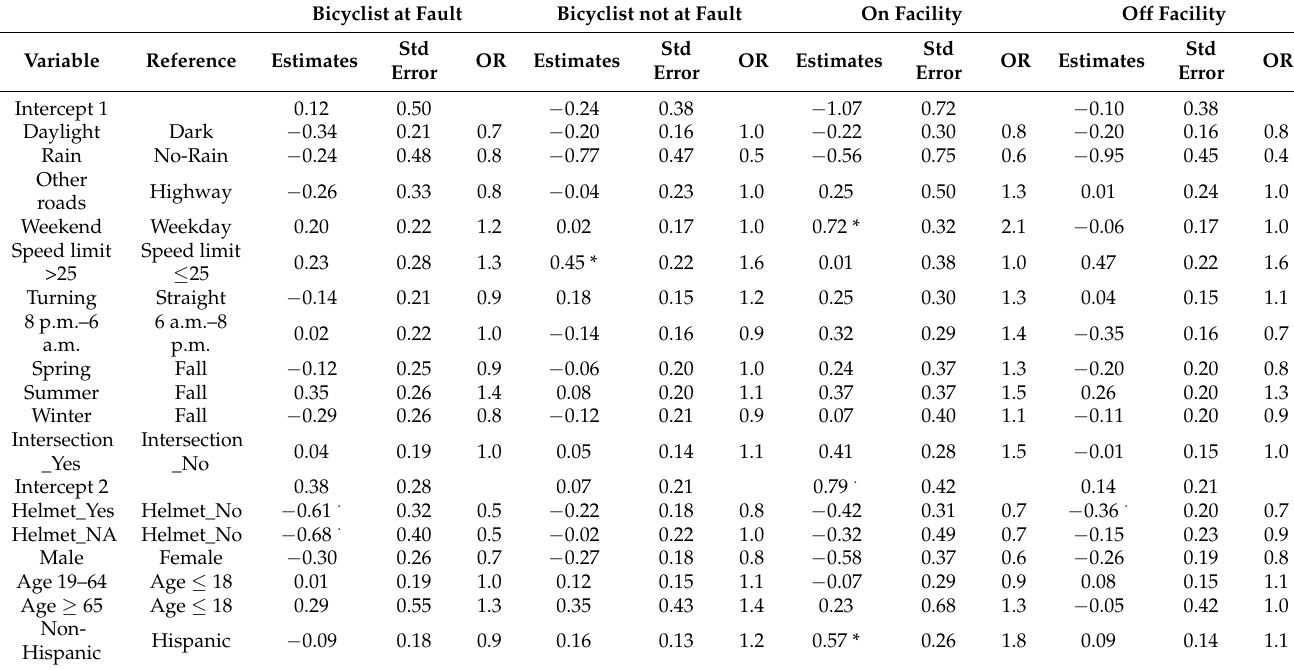
Table 6. Logistic regression model results for any injury (KAB) based on party at fault and bicycle facility presence. Bicyclist at Fault Bicyclist not at Fault On Facility Off